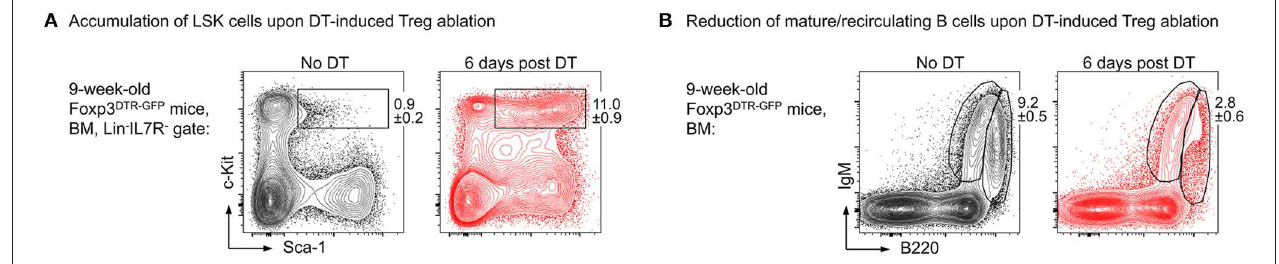
FIGURE 2 | Impact of Foxp3 + Treg cell ablation on the BM niche. Foxp3 DTR − GFP mice were i.p. injected with DT on 3 consecutive days and the BM was analyzed at day 6 after the first DT dose by flow cytometry. Representative plots of (A) LSK (Lineage − IL7R − Sca-1 + c-Kit + ) cells and (B) mature/recirculating B cells (B220 high IgM + ) in the BM of 9-week-old untreated (left) and DT-treated (right) mice.